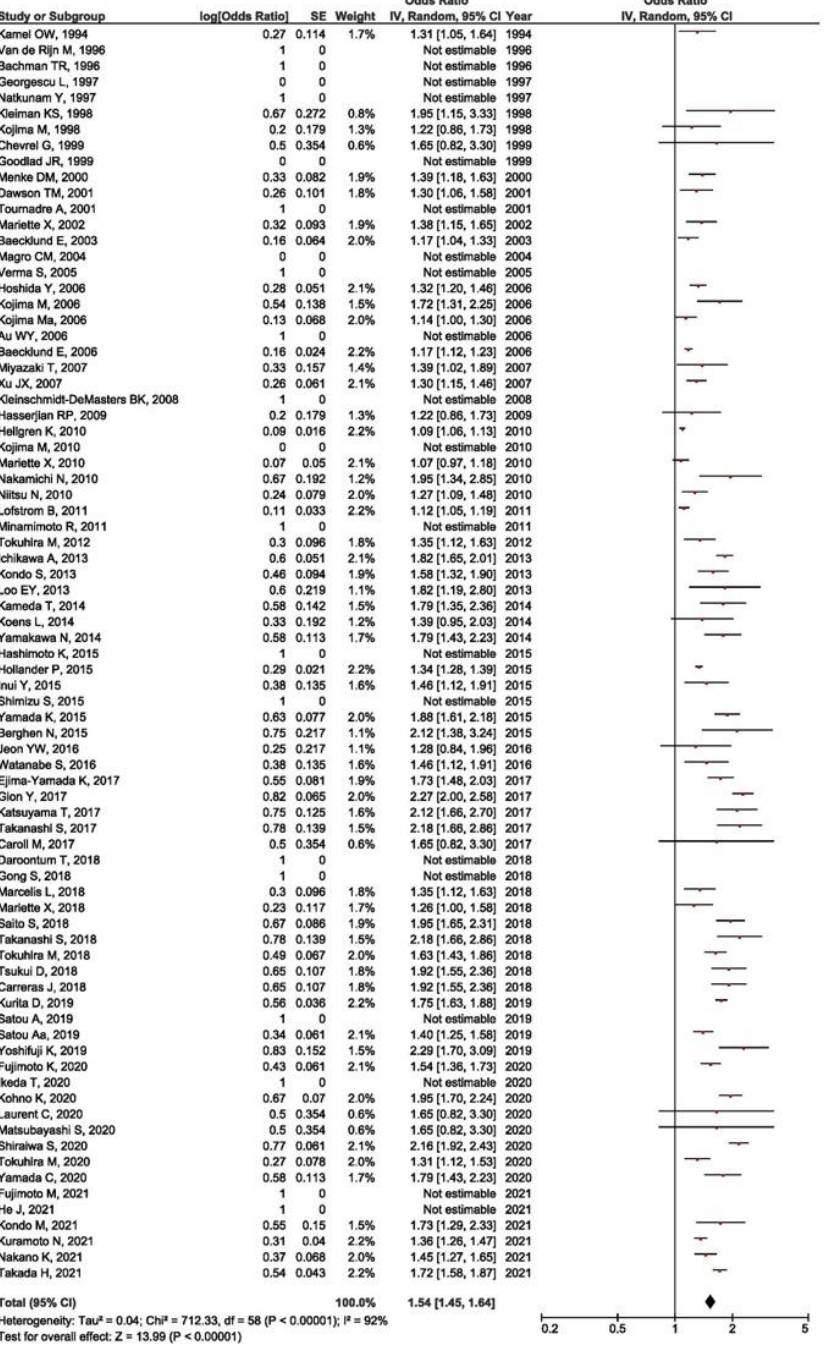
Figure 2. Meta-analysis of the prevalence of positive EBV result in RA-LPD patients (red dot represents the point estimate—prevalence and black frame represents 95%CI of the point estimate for the data from each of included studies) .